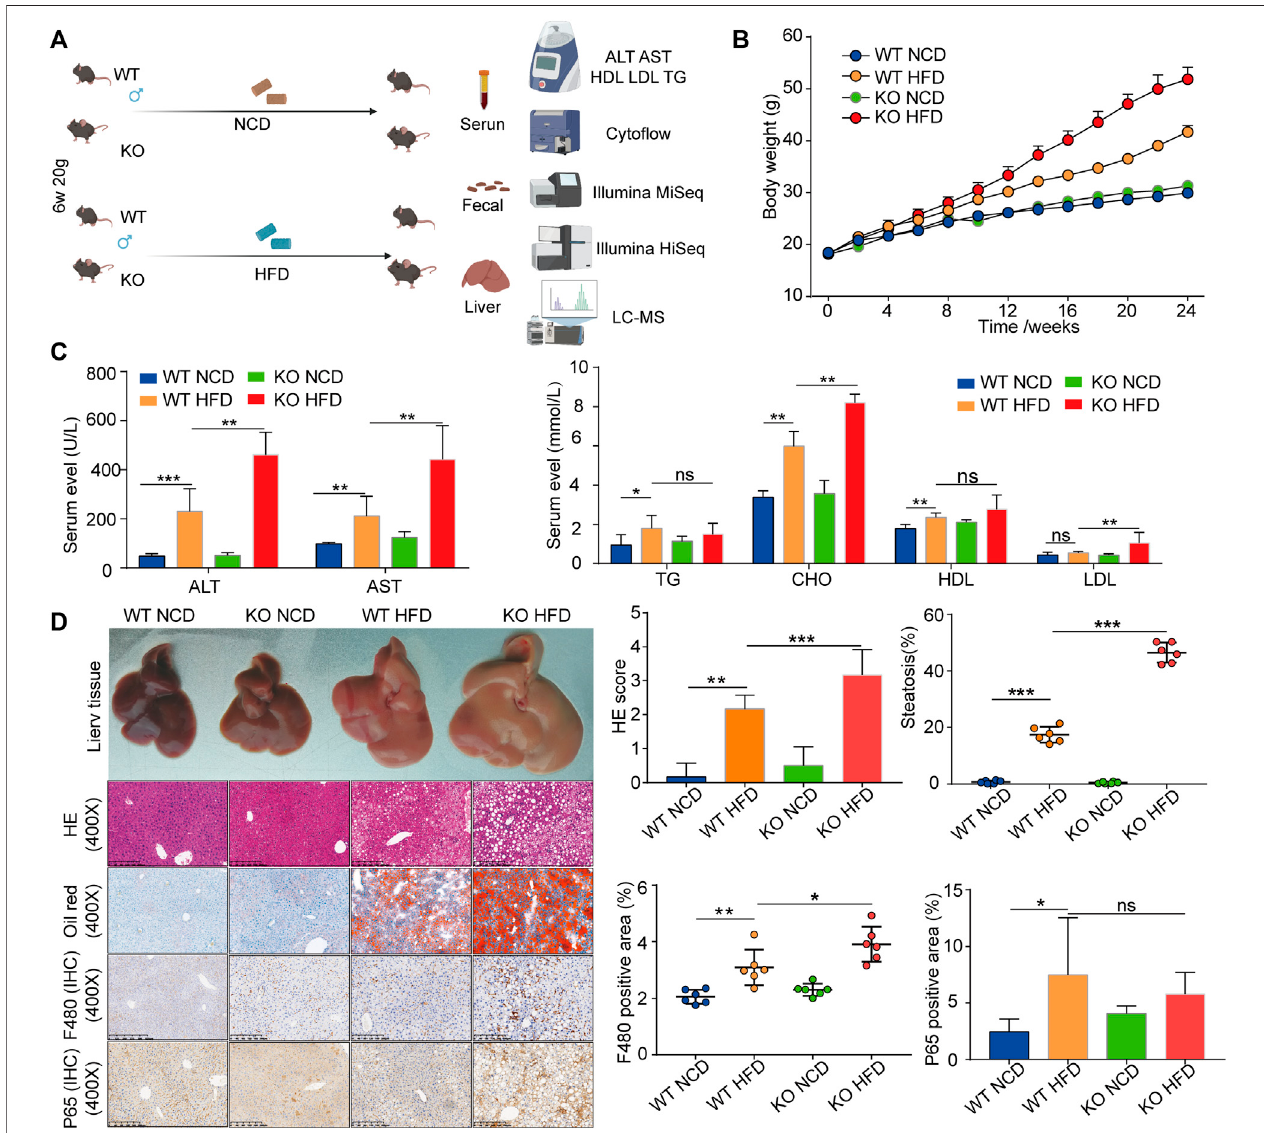
FIGURE2| TheCD1dKOmicefedanHFDdisplayincreasedbodyweights,liversteatosis,liverinjury,andfataccumulation. (A) WTmiceandCD1dKOmicewere fedHFD and NCDfor24 weekstoinduce theNAFLDmouse model. (B) Bodyweight curves offourgroups. (C) Serum ALT,ALT, TG,TC,HDL,LDLexpression levels in the four groups. (D) Gross morphology, H&E staining, Oil Red O staining, Masson ’ s trichrome staining, immunohistochemistry staining of F480 and p65 of liver tissues between four groups. ALT, alanine aminotransferase; AST, aspartate aminotransferase; HDL, high-density lipoprotein; H&E, hematoxylin and eosin; HFD, high-fat diet;KO, knockout;LDL,low-densitylipoprotein; NCD,normalcontroldiet;NAFLD,nonalcoholicfattyliverdisease;TC,totalcholesterol; TG,triglyceride;WT,wild-type.